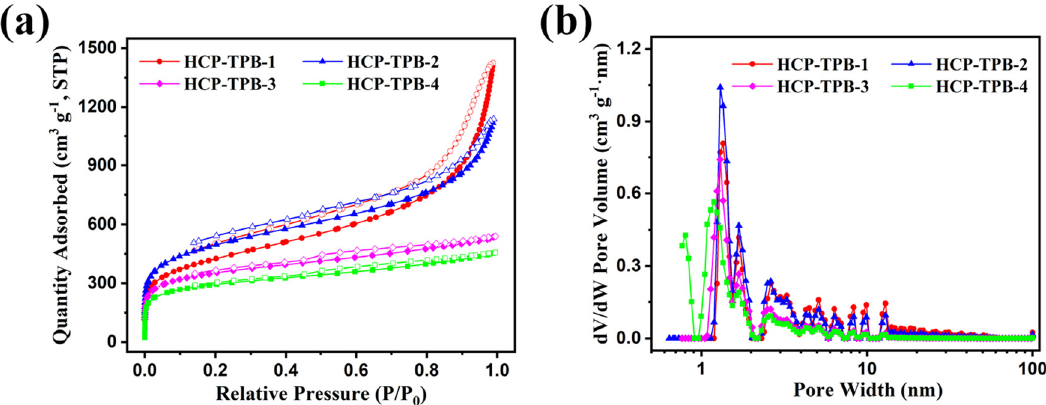
Figure 7: ( a ) Nitrogen adsorption/desorption isotherms and ( b ) pore size distributions of HCPs prepared with the increasing amount of crosslinker.